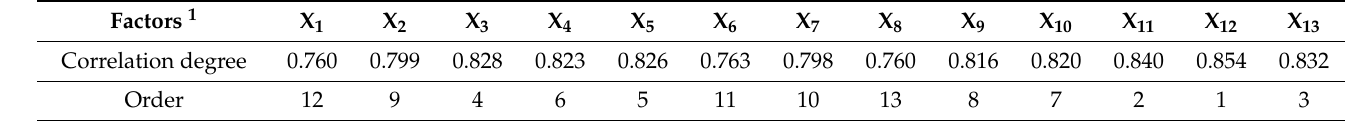
Table 2. Analysis of correlation degree between dissolved N 2 O concentration and its influencing